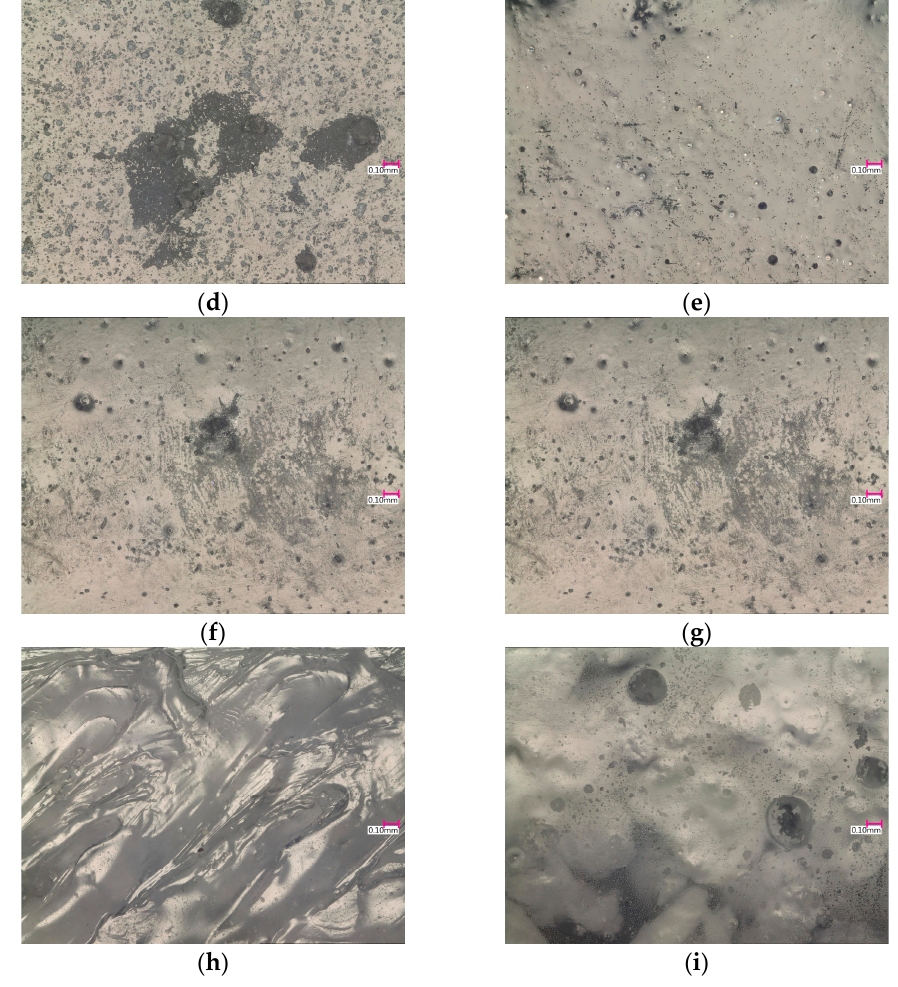
Figure 2. Microscopic photos of the fragments of specimens made with mixtures of ( a ) epoxy resin E601 and additive, ( b ) ESO3, ( c ) ESO10, ( d ) MC3, ( e ) MC10, ( f ) CMC3, ( g ) CMC10, ( h ) EC3 and ( i ) EC10.